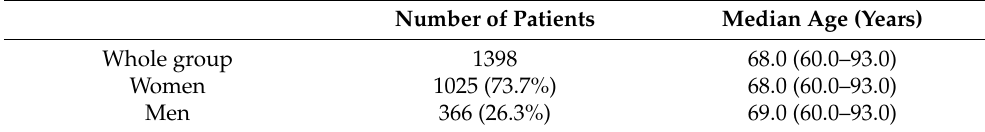
Table 1. Demographic characteristics of the